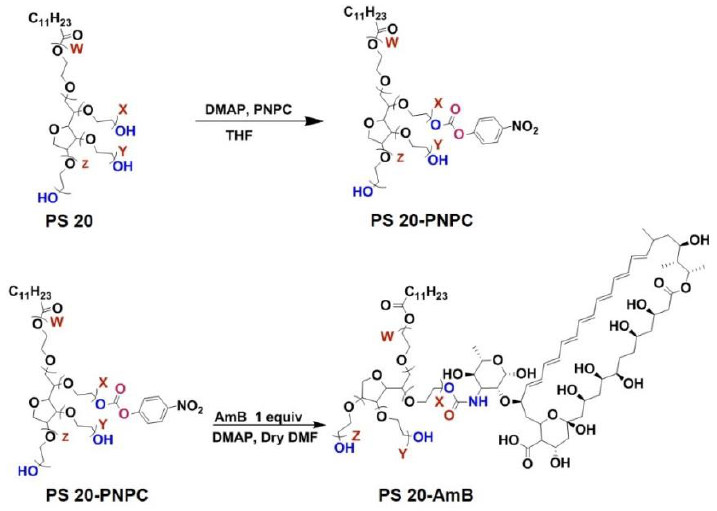
Figure 5. Synthesis of PS 20-AmB conjugates. Hydroxyl groups of PS were activated with para-nitrophenyl chloroformate (PNPC), followed by conjugation with amphotericin B (AmB) in the presence of dimethylaminopyridine (DMAP). THF: tetrahydrofuran, DMF: dimethylformamide. Reproduced with permission from Reference [110]. Copyright 2018, Bentham Science.